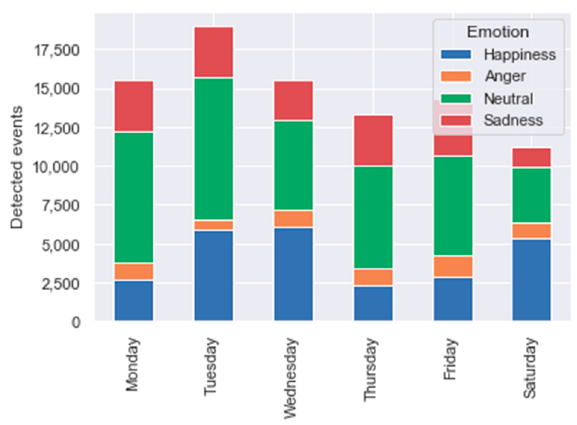
Figure 7. Emotion identification of the HA/HV, HA/LV, LA/HV, LA/LV states week 1.